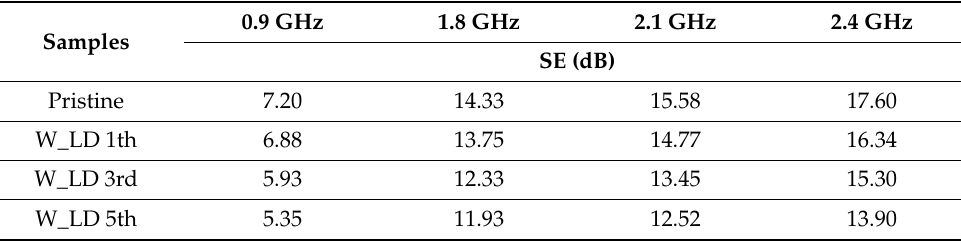
Table 5. Shielding effectiveness (EMSE) of stainless-steel fabric sample (face) before and after the 1st, 3rd, 5th, 7th, and 10th cycles of washing with liquid detergent at frequencies 0.9 GHz, 1.8 GHz, 2.1 GHz, and 2.4 GHz .